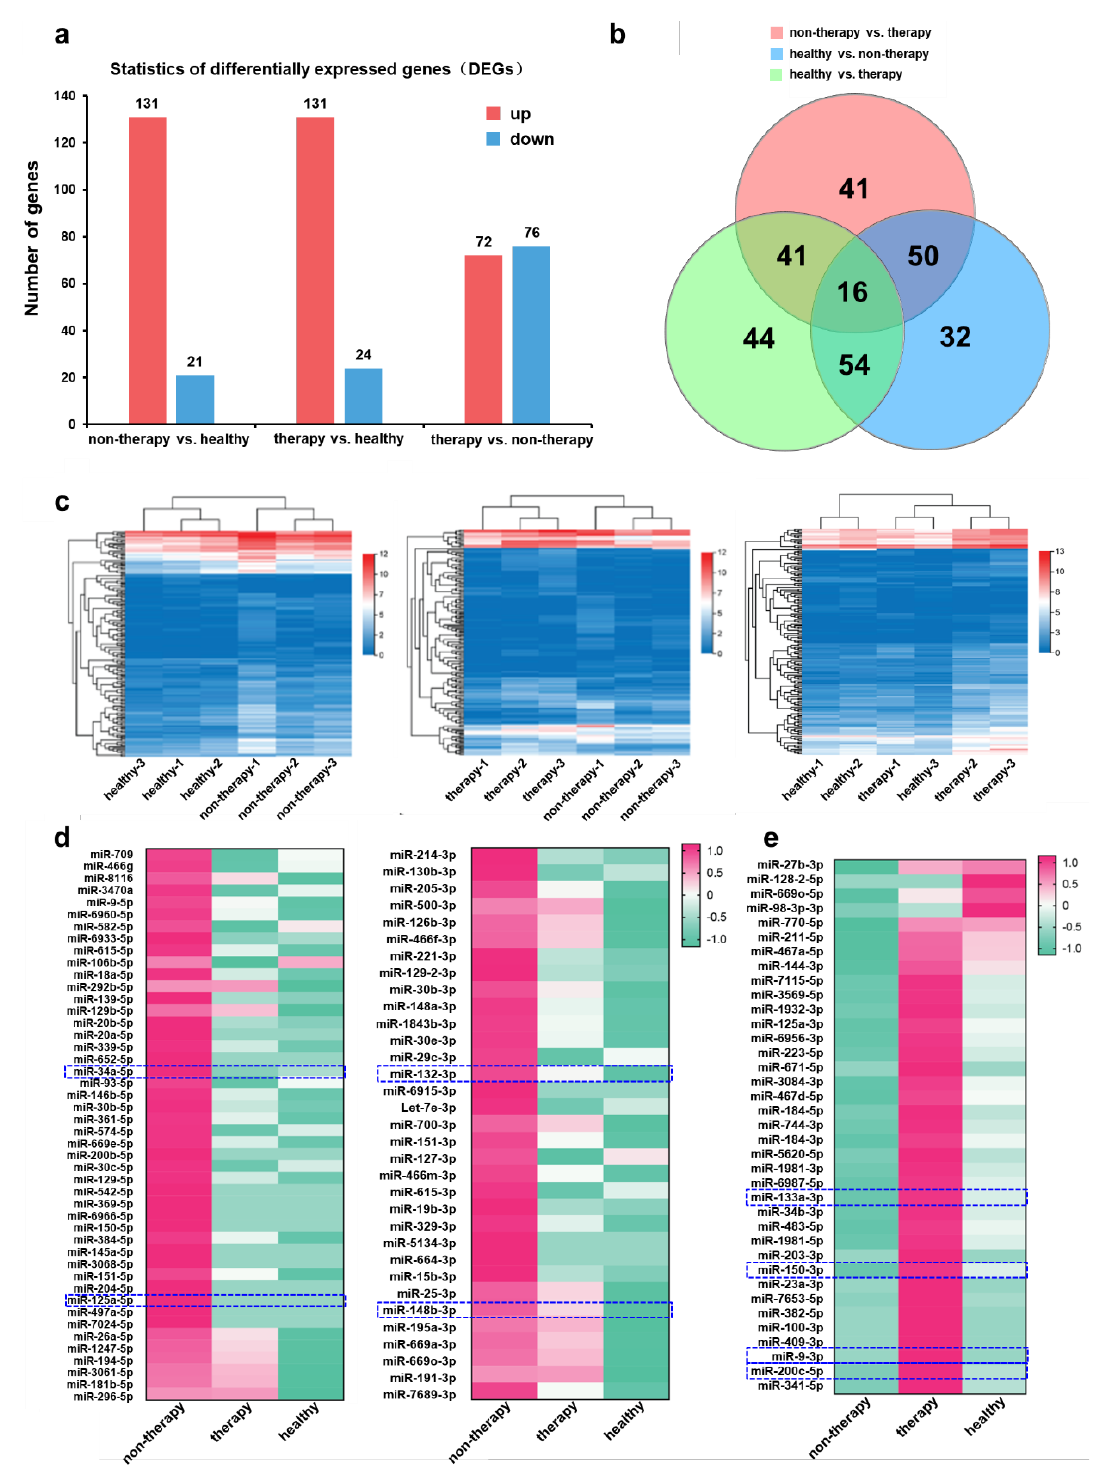
Figure 6. miRNA expression analysis. ( a ) Statistical analysis of differentially expressed genes (DEGs) from non-therapy vs. healthy group, therapy vs. healthy group, and therapy vs. non-therapy group, respectively. ( b ) Plot showing the differentially expressed genes from two different groups in the non-therapy group, therapy group, and healthy group. ( c ) DEGs cluster heatmaps showing healthy group vs. non-therapy group, therapy group vs. non-therapy group, and healthy group vs. therapy group, respectively. ( d ) The down-regulated miRNAs caused by PEG-ReS 2 -based PTT in non-therapy group, therapy group, and healthy group, respectively. ( e ) The up-regulated miRNAs caused by PEG-ReS 2 -based PTT in non-therapy group, therapy group, and healthy group, respectively.